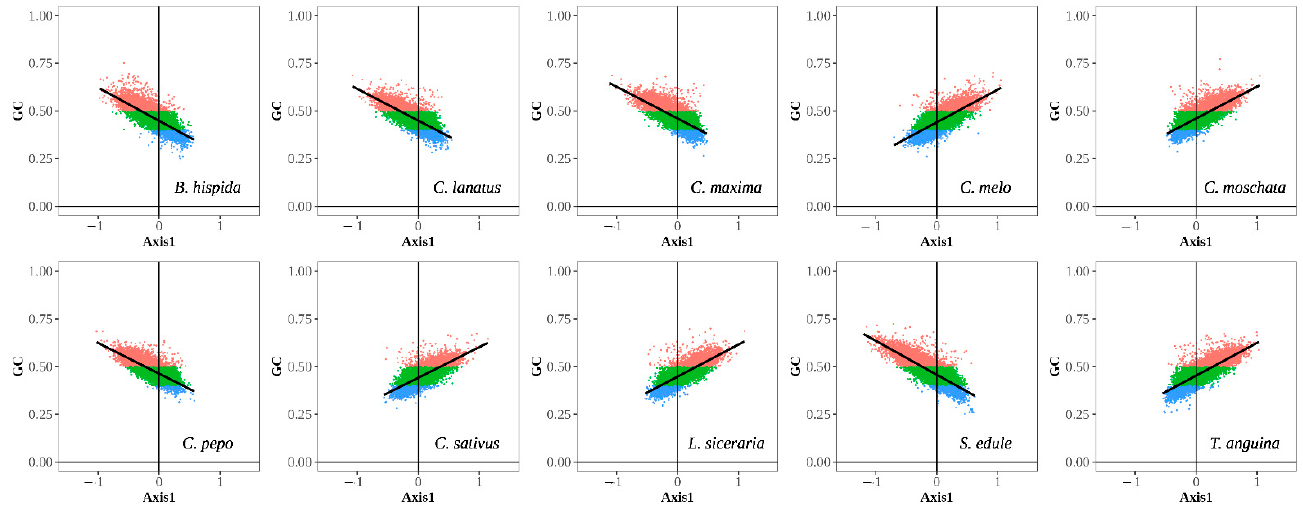
Figure A1. Correspondence analysis of genes in ten species of Cucurbitaceae: the distribution of genes is shown along the first axis and GC content. The vertical axis represents the GC content, and the horizontal axis represents the first Axis. Note: The red, green, and blue dots represent the genes with GC content higher than 60%, within 45–60%, and lower than 45%. Bold black line represents the linear regression line. Here, the regression equation and the correlation coefficients of GC12 and GC3 of each graph are as follows: Bhi: y = − 0.174x + 0.448, r = − 0.810, p < 0.01; Cla: y = − 0.166x + 0.449, r = − 0.810, p < 0.01; Cma: y = − 0.167x + 0.46, r = − 0.811, p < 0.01; Cme: y = 0.171x + 0.441, r = 0.784, p < 0.01; Cmo: y = 0.167x + 0.461, r = 0.812, p < 0.01; Cpe: y = − 0.161x + 0.463, r = − 0.824, p < 0.01; Csa: y = 0.160x + 0.441, r = 0.770, p < 0.01; Lsi: y = 0.168x + 0.447, r = 0.811, p < 0.01; Sed: y = − 0.178x + 0.457, r = − 0.865, p < 0.01; Tan: y = 0.171x + 0.453, r = 0.839, p < 0.01.